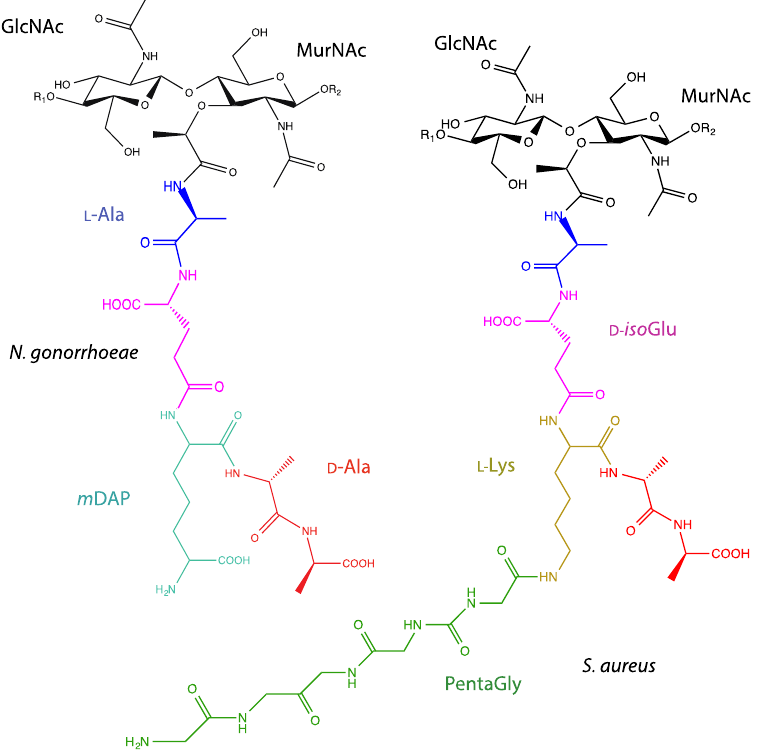
Figure 1. Structure of N. gonorrhoeae and S. aureus PG. The PG sacculus is composed of repeating units of GlcNAc- β (1 → 4)-MurNAc where the C-3 lactyl moiety of MurNAc is decorated with a stem peptide chain. The stem peptide varies the greatest between the two main classifications of bacteria. R 1 and R 2 denote the extending repeat units commencing with MurNAc or GlcNAc residues, respectively.